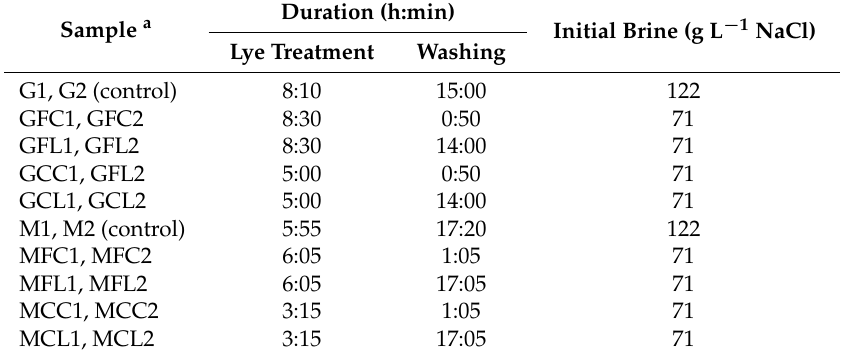
Gordal (G) and Manzanilla (M) cultivars, respectively. The ambient temperature was 24 ◦